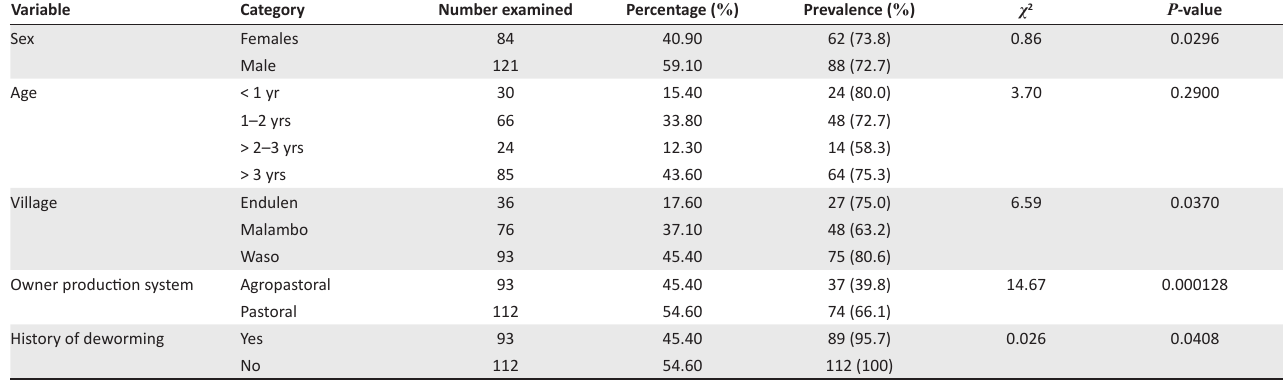
TABLE 1: Proportions of dogs and prevalence of Taenia spp. infection in each category of each variable investigated during the study ( n = 205). Variable